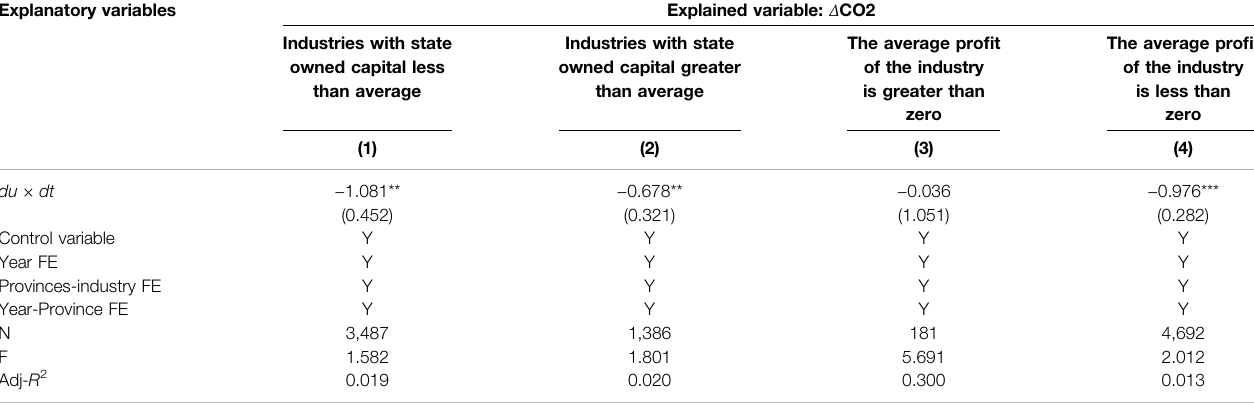
TABLE 9 | Industry heterogeneity